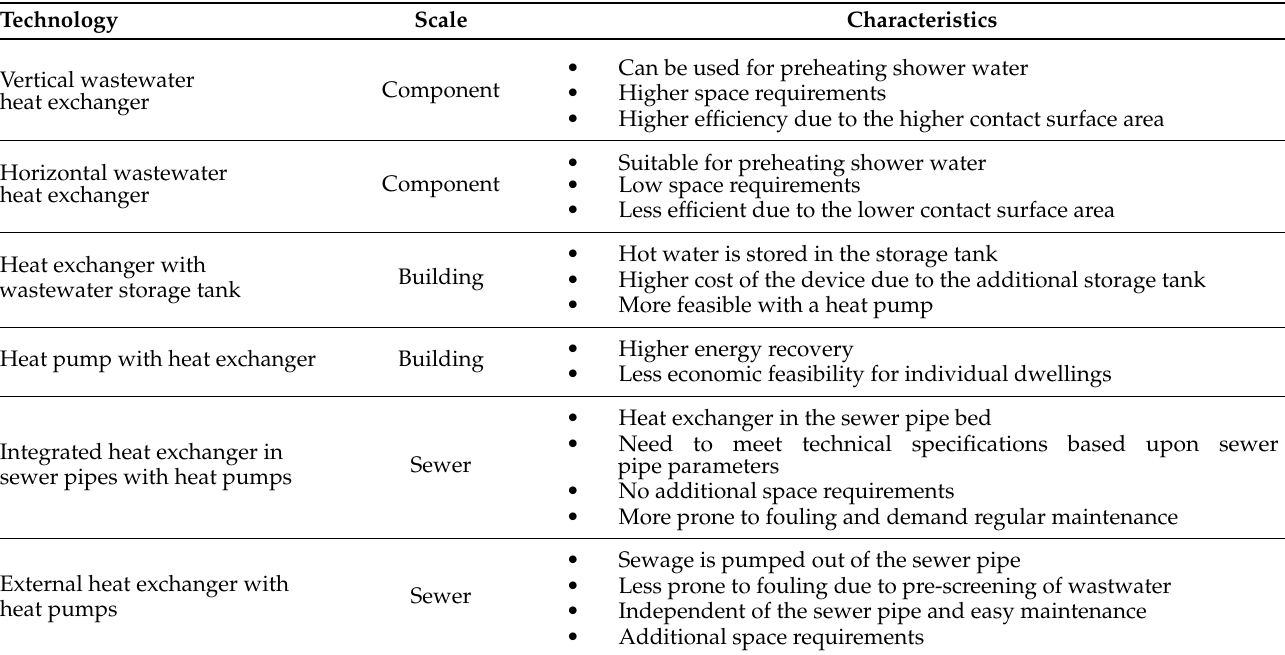
Table 2. Summary for wastewater heat recovery